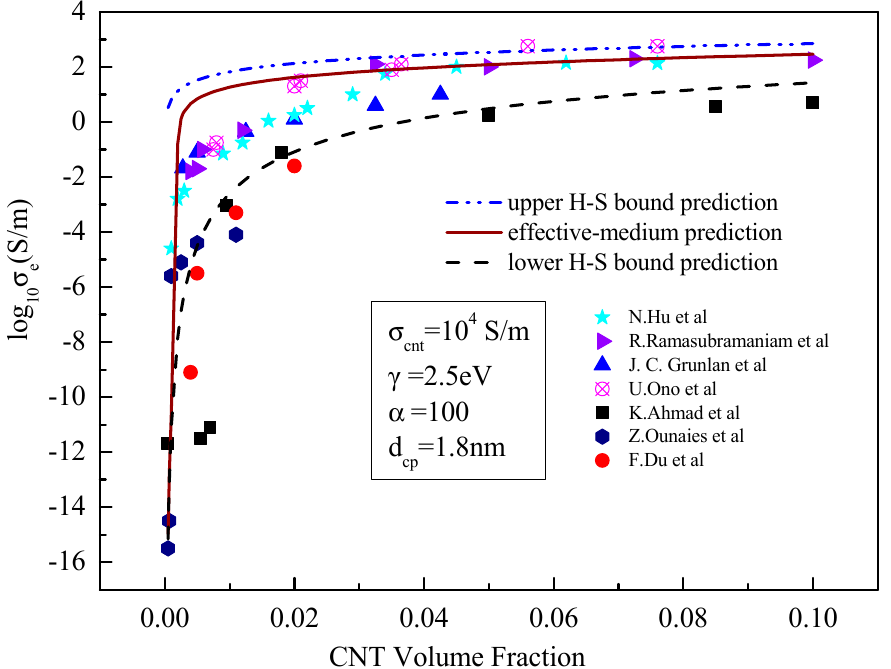
Figure 3. Comparison between the prediction results and existing experimental data [21,23–28] con- sidering the tunnelling